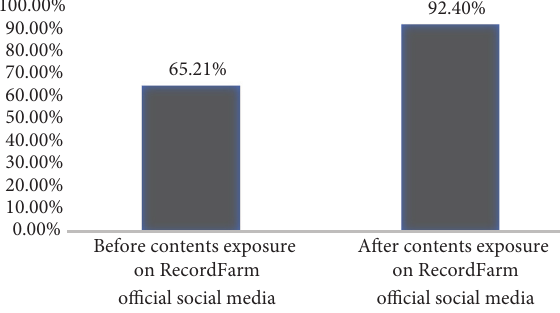
Figure 3. User satisfaction